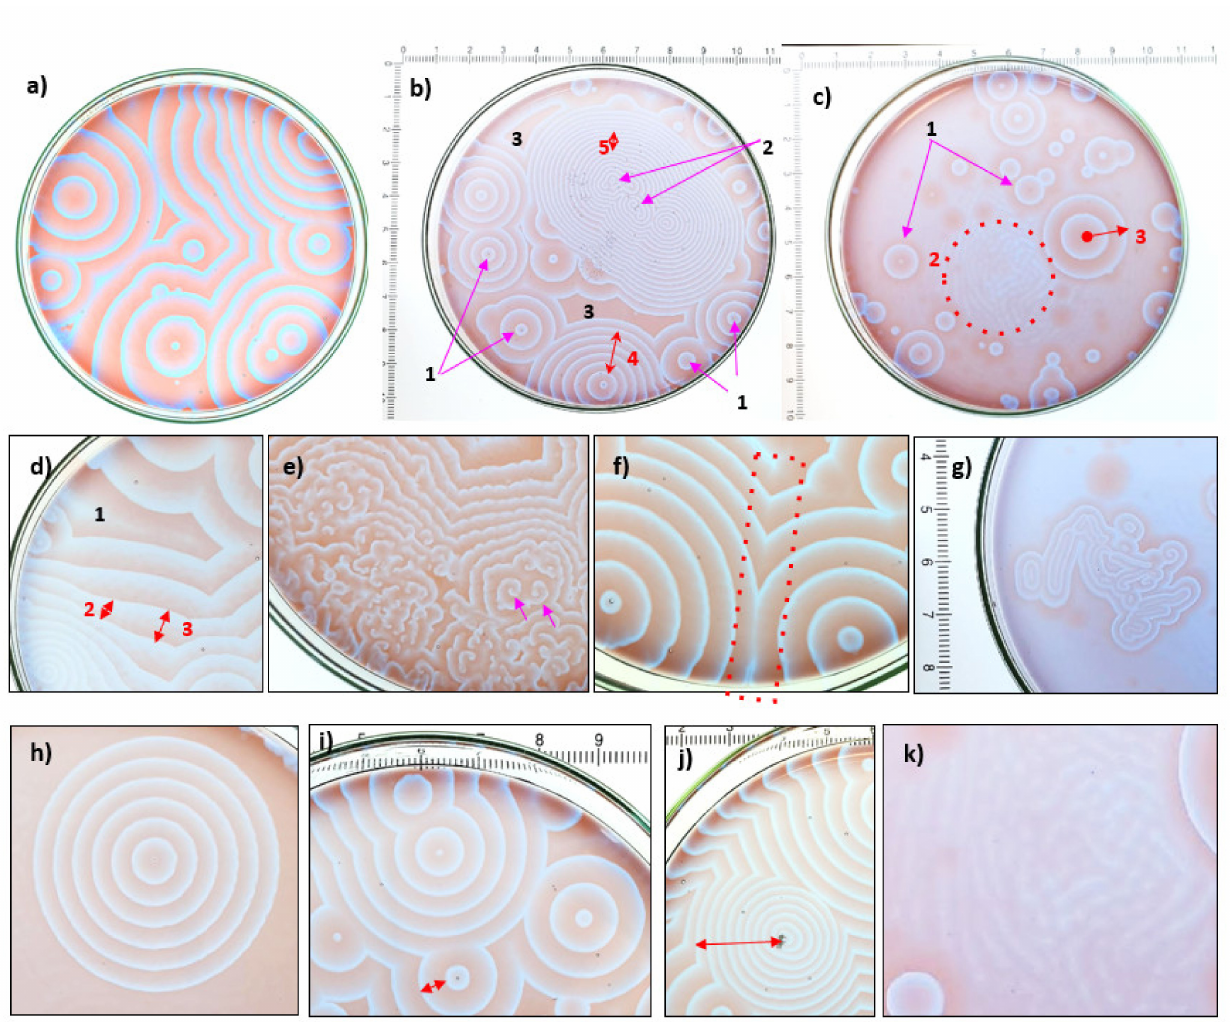
Figure 2. The most common types of self-similar patterns produced for this work by the classical B-Z reaction in Petri dishes 10 cm in